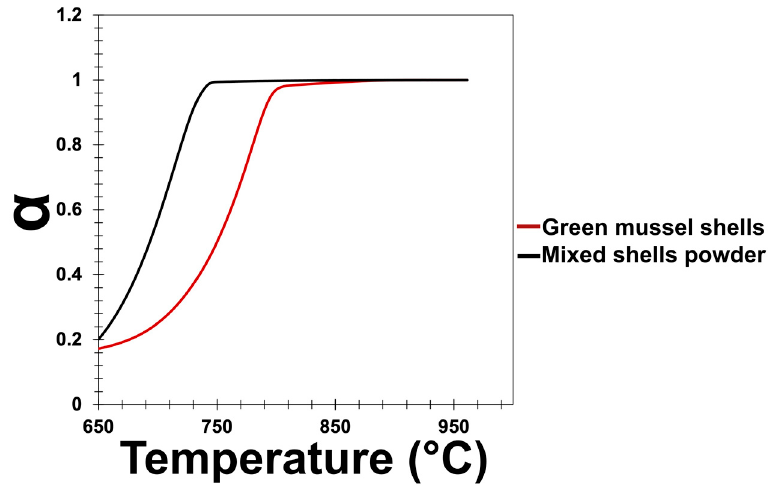
Figure 3. The fraction of decomposed green mussel shells and mixed shell powder .